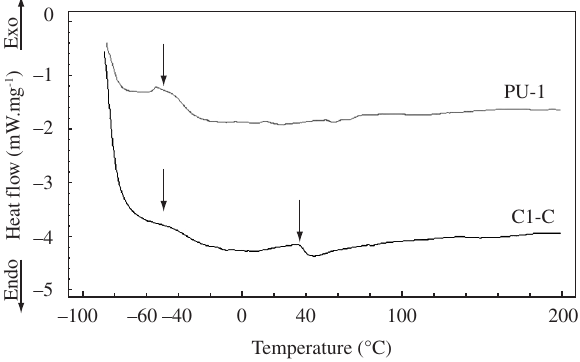
Figure 11. DSC curves of the PU-1 and inorganic modified PU-1